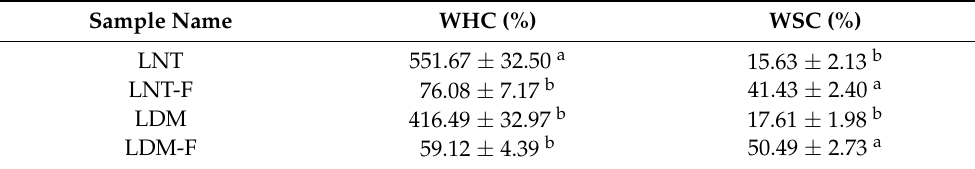
Table 3. Water-holding capacity (WHC) and water solubility capacity (WSC) of lentinan